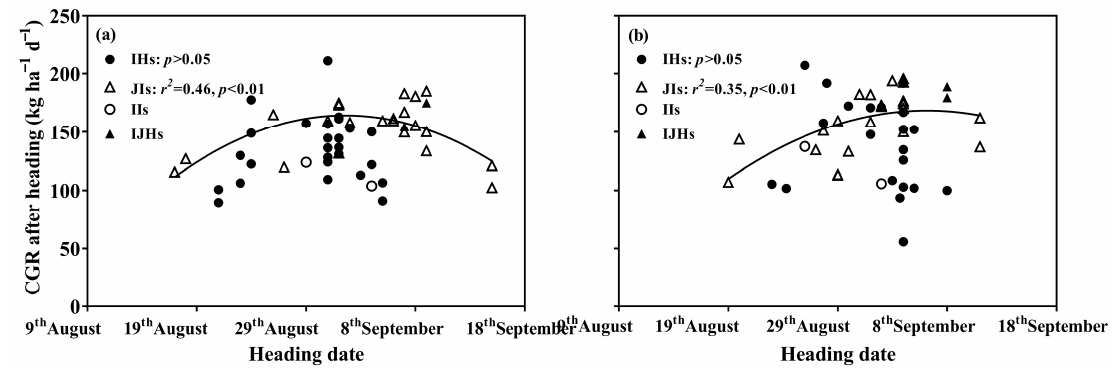
Figure 8. Relationship between yield and CGR after heading in 2017 ( a ) and 2018 ( b ). IJHs, indica- japonica hybrids; IHs, indica hybrids; JIs, japonica inbreds; IIs, indica inbreds. p < 0.05, significant at the 0.05 probability level according to the LSD test; p < 0.01, significance at the 0.01 probability level according to the LSD test.